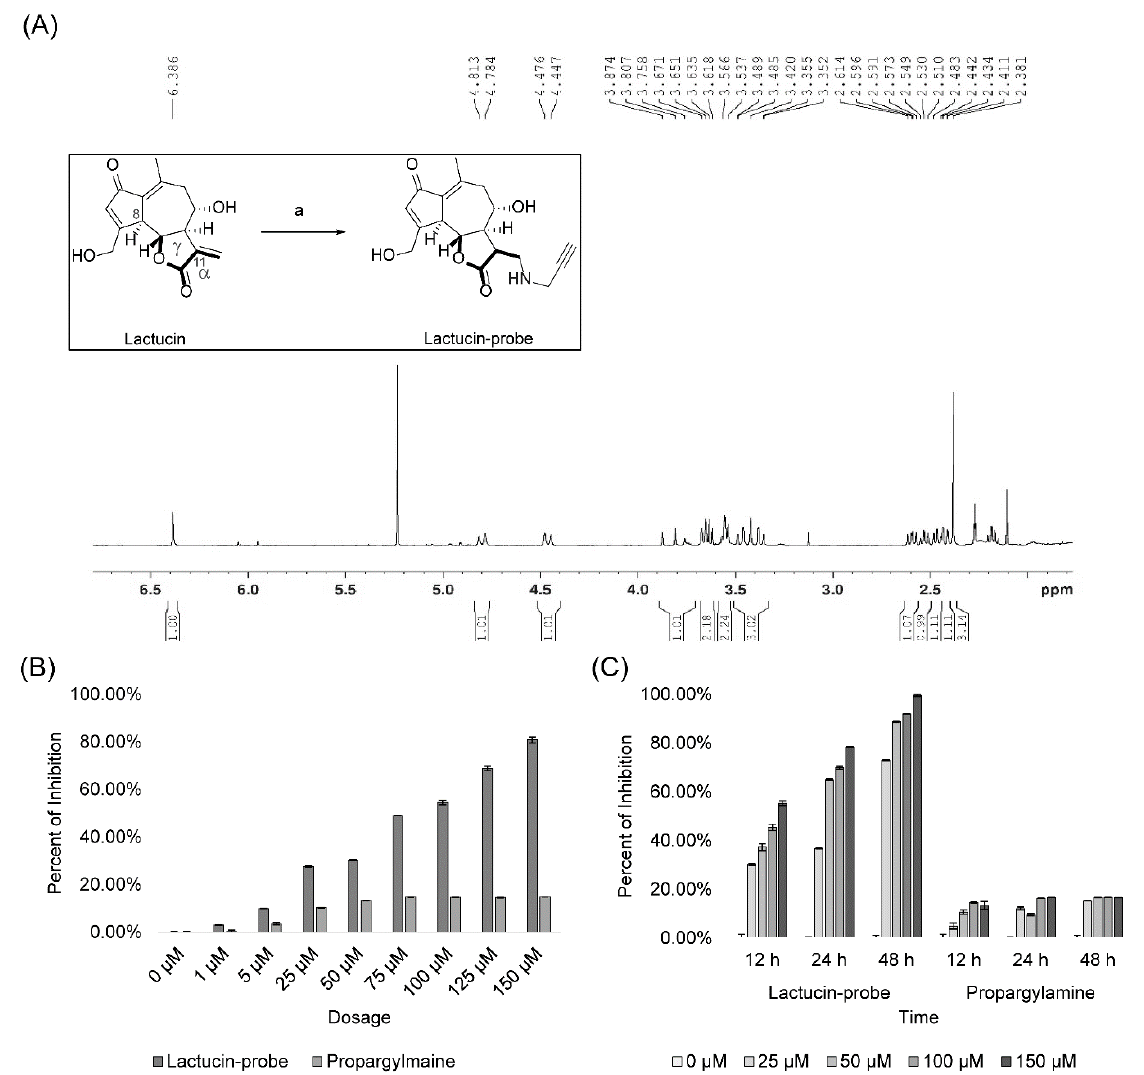
Figure 5. The structure of Lactucin-Propargylamine conjugate was confirmed using 1H NMR ( A ). Inset showing schematics of synthesis of Lactucin probe where reagents and conditions for synthesis were (a) propargylamine, pyridine, 0 °C, 36 h. Upon cytotoxicity evaluation on A549 cells, the Lactucin probe showed similar bioactivity as natural Lactucin compared to Propargylamine in incremental dose ( B ) and progressive dosing time ( C ) experiments.